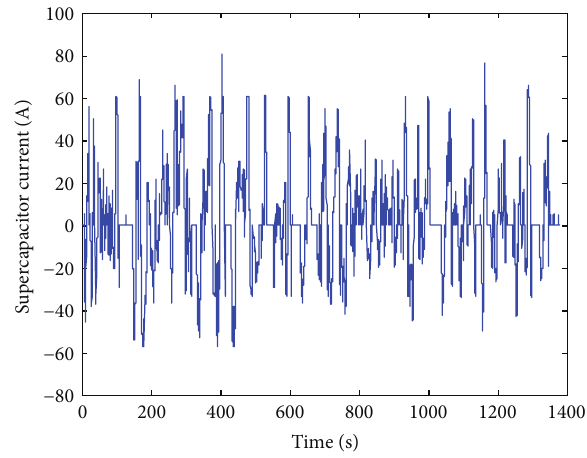
Figure 20: Supercapacitor current.